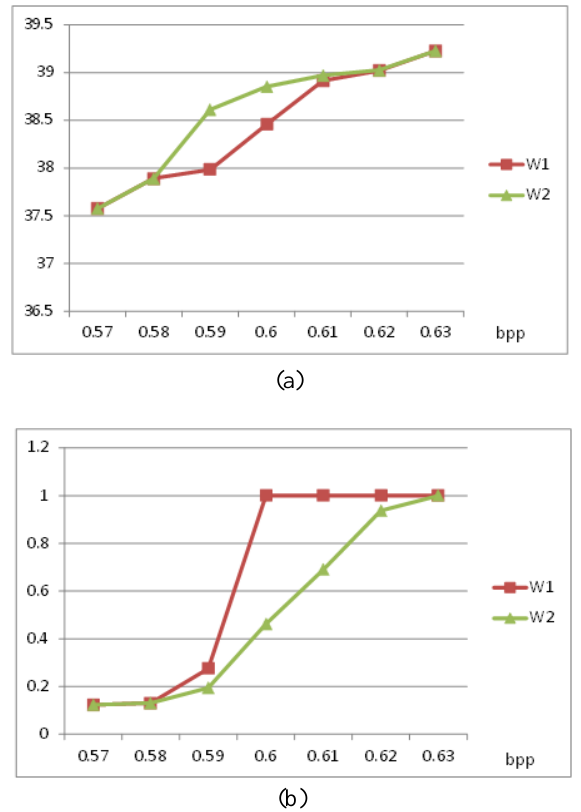
Fig. 9 (a) PSNR and (b) NC comparison between the whole massage embedding (W1) and the partial message embedding